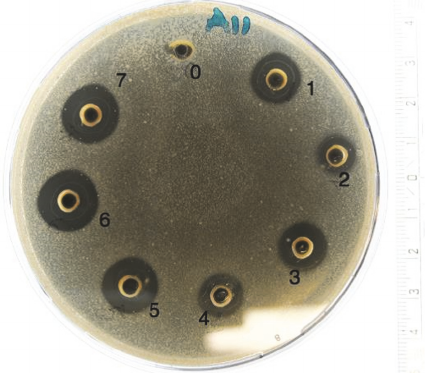
Figure 1: Photo of an agar-dish after agar-well diffusion assay. The dish is inoculated with Staphylococcus aureus (CCUG 1800) and honeys 1-7 are added in the wells. Milli-Q water serves as reference [0] .